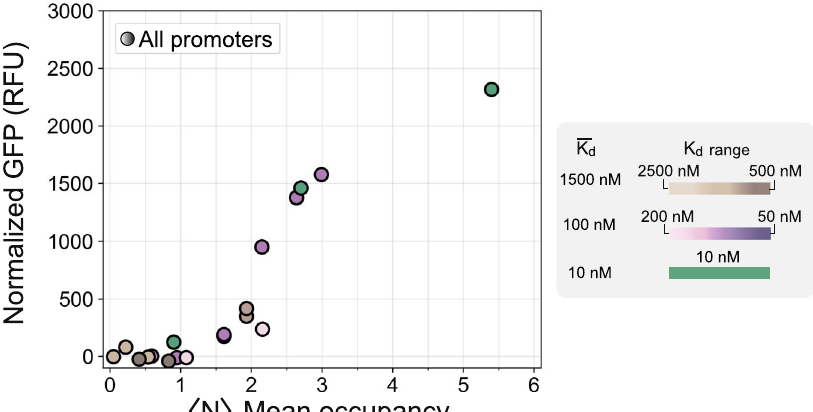
Fig.6|Thresholdedgeneactivation. Thresholdedrelationshipofgeneexpression (GFPnormalizedbyOD600)asafunction of predicted mean occupancy(basedon